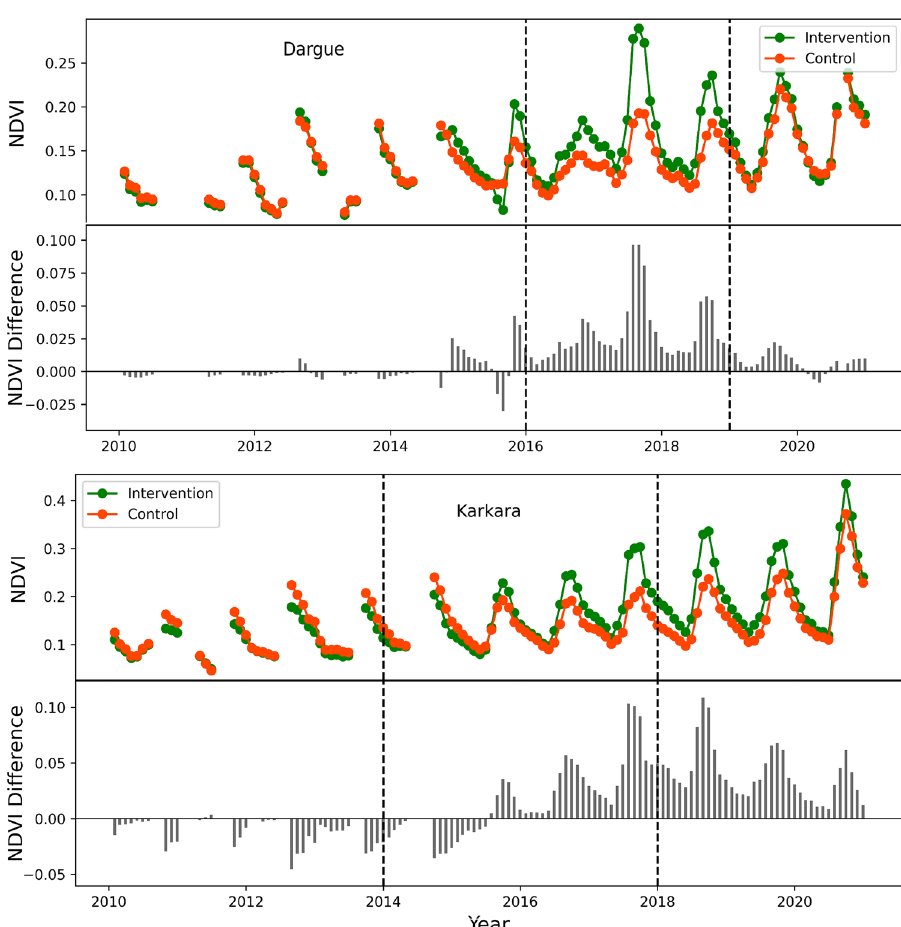
Figure 5. NDVI values at the control and intervention sites from 2010 to 2020 for Dargue and Karkara. The vertical lines show the beginning and end of control/experiment periods.